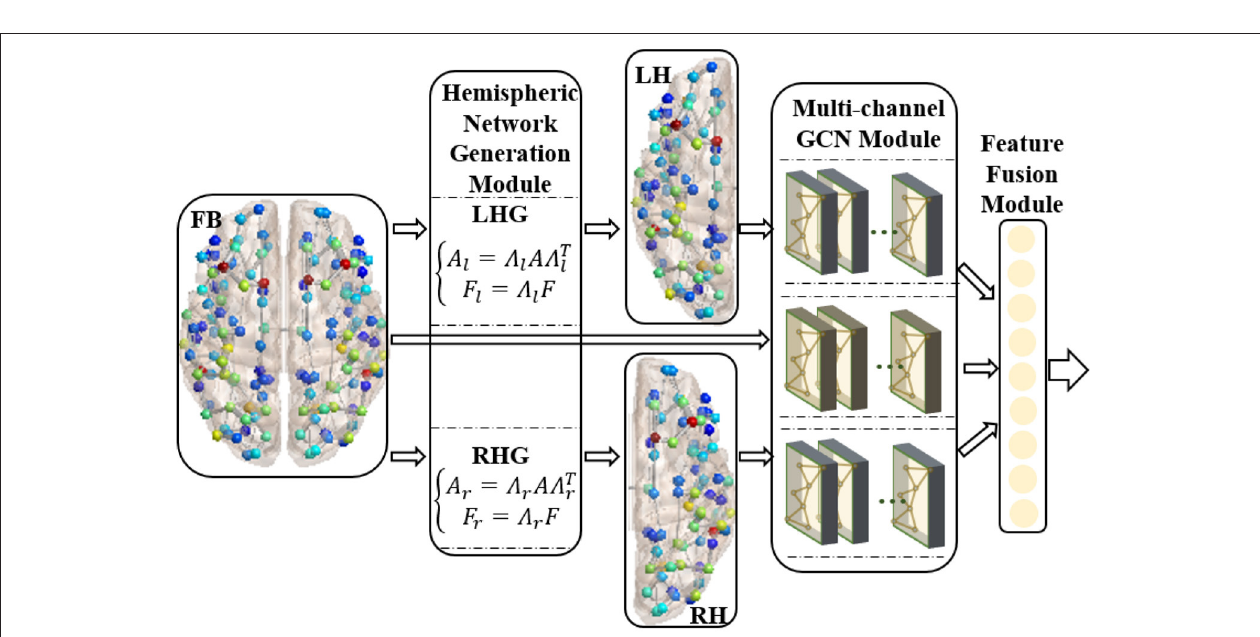
FIGURE 2 | Regional brain fusion framework. FB, LH, and RH denote full brain network and left and right hemispheric subnetwork, respectively. LHG and RHG separately denote left and right hemispheric network generation modules. FB and LH generated by LHG and RH generated by RHG are input to the corresponding channels in the multichannel GCN module, and then the extracted representation information is merged in the feature fusion